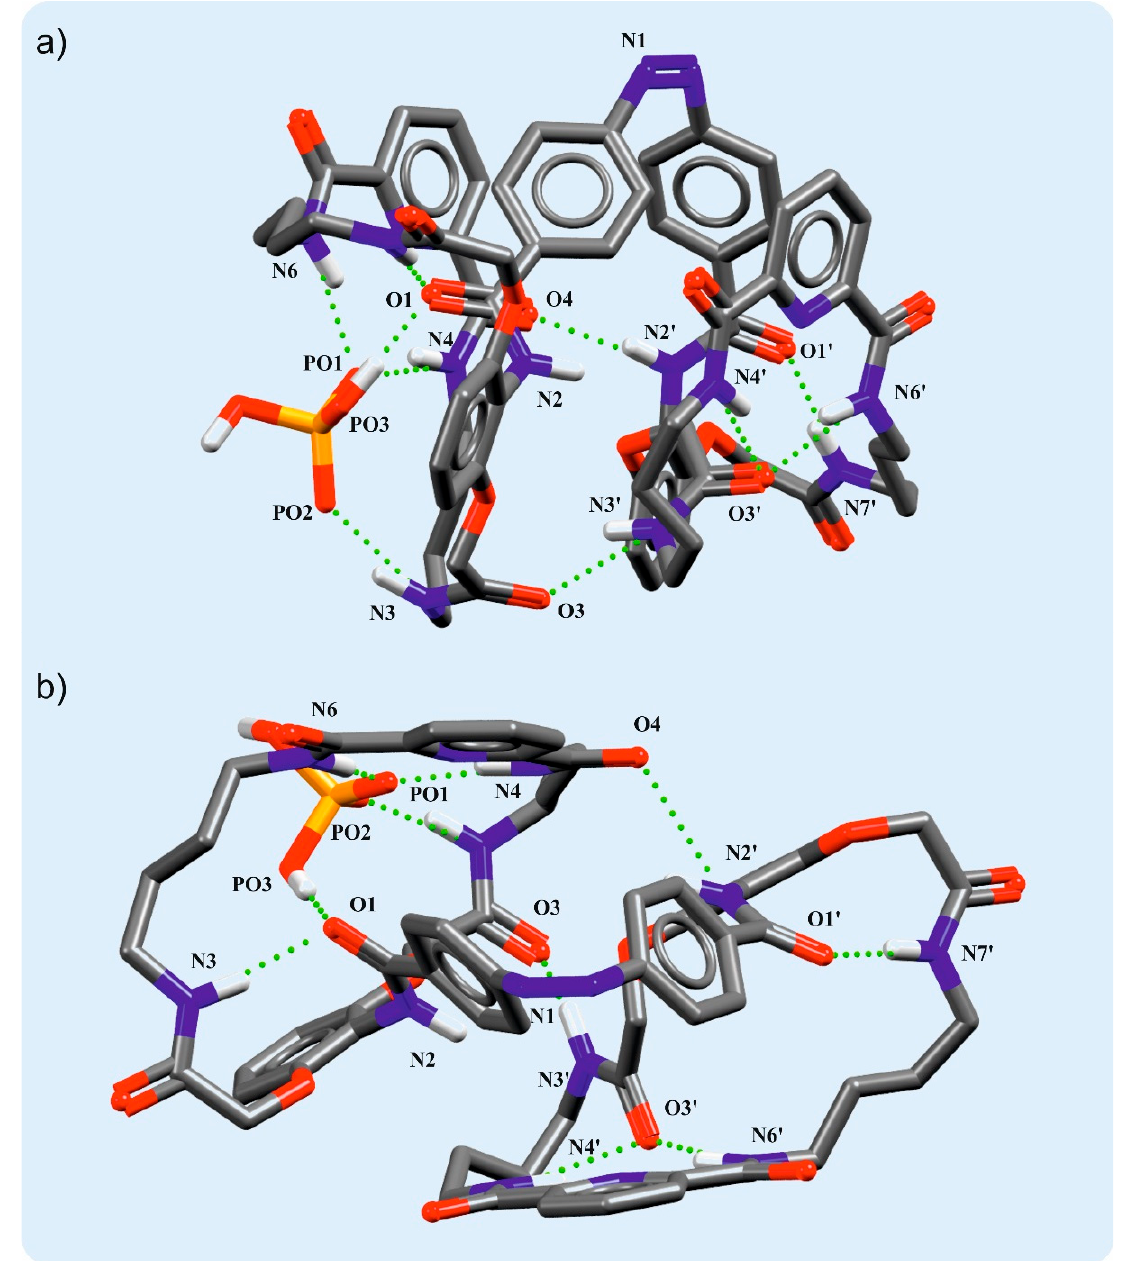
Figure 3. Side ( a ) and top ( b ) views of the energy-minimized structure of cis - 1 -H 2 PO 4 − anionic com- plex (DFT/B3LYP-D3/6-31G(d)/C-PCM:DMSO), illustrating a highly compact host–guest